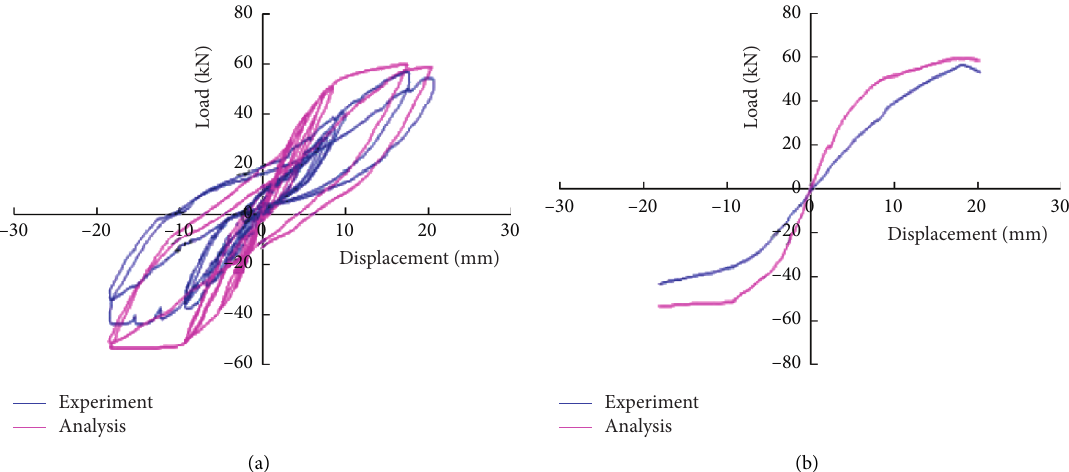
Figure 11: Comparison of the hysteretic curves and skeleton curve of model 2 (after): (a) hysteretic reinforcement; (b) skeleton reinforcement.